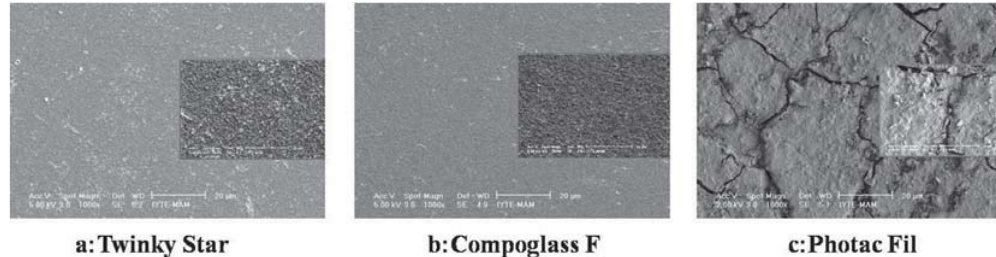
Figure 3- SEM micrographs of the specimens after distilled water